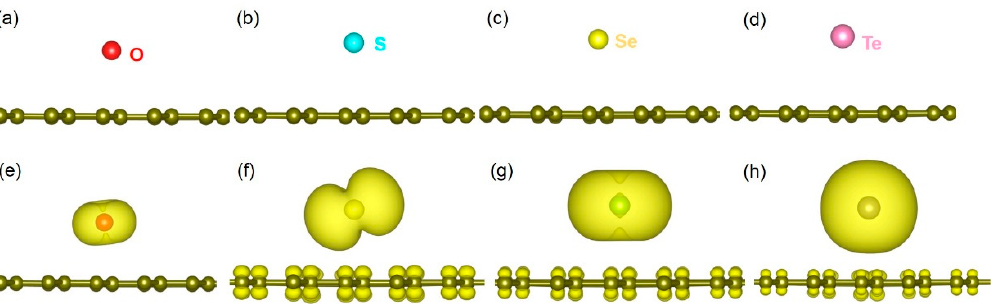
sponding charge density plots associated with the adsorbed configurations (e – h) are also shown.